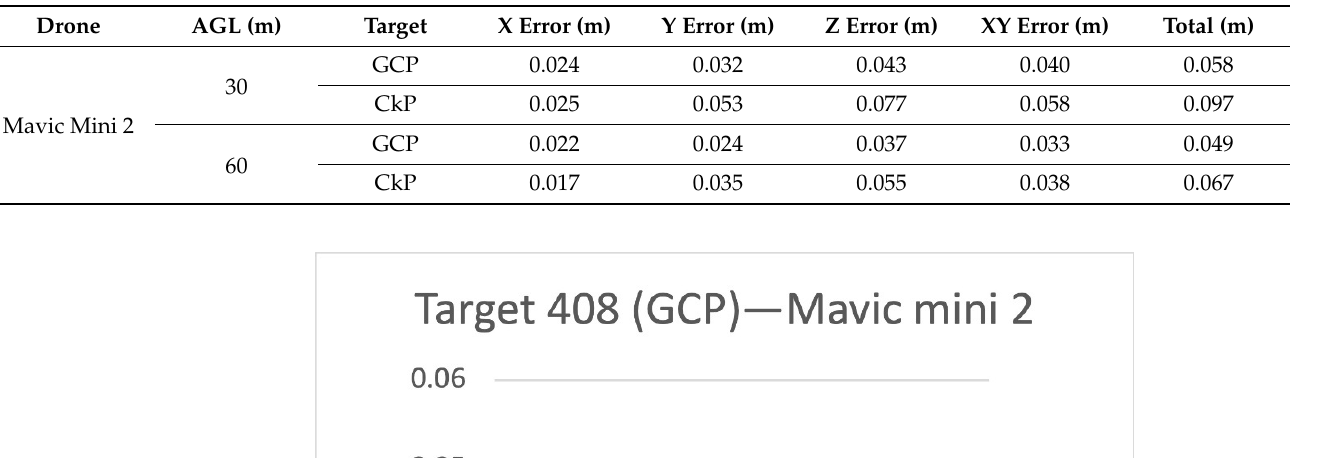
Table 6. Residuals on GCP and CkP for the survey made by the Mavic Mini 2 Adv at different AGLs. Total represents the total error of the 3 components.